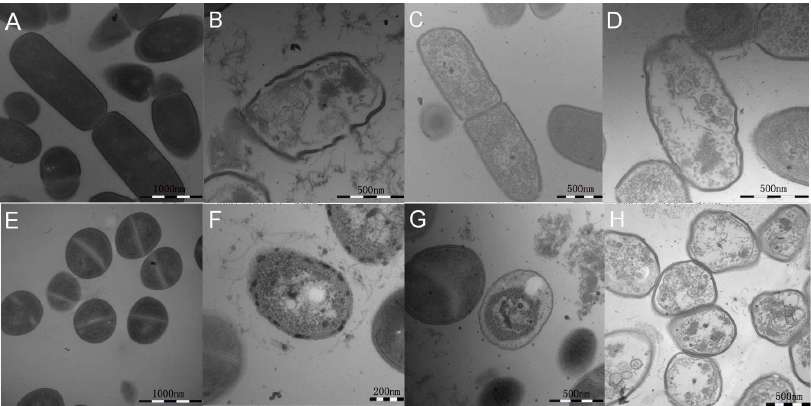
Figure 7. Transmission electron microscopy (TEM) micrographs of E. coli ATCC 25922 and S. aureus ATCC 29213 cells treated with the peptides at their 1 × MICs at about 1 h. E. coli ATCC 25922: